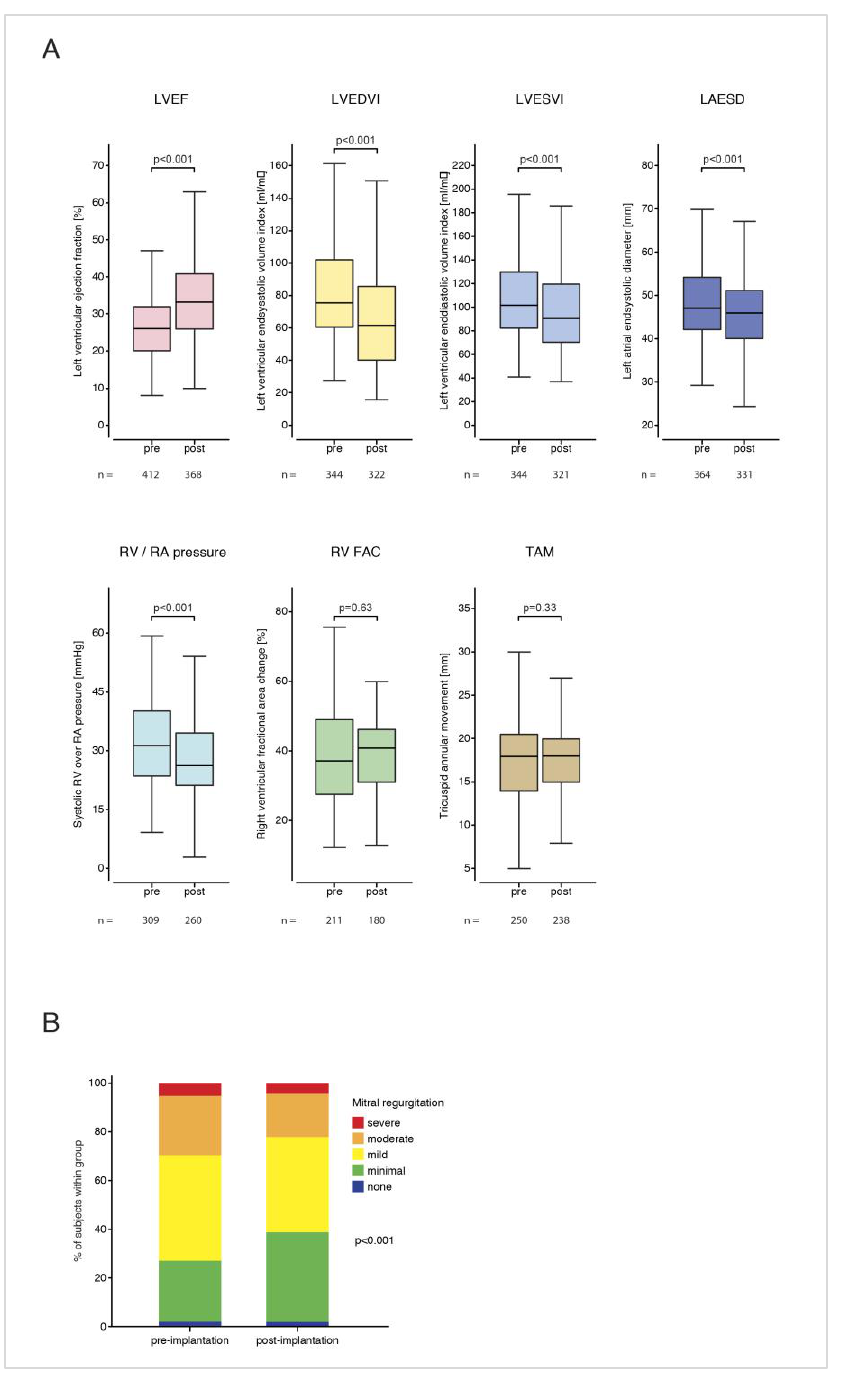
Figure 2: Effects of cardiac resynchronisa- tion therapy (CRT) on echocardiographic re- verse remodelling. Comparisons pre- vs post-CRT implantation of echocardio- graphic parameters of cardiac remodelling. (A) Comparisons of LVEF (left ventricular ejection fraction), LVEDVI (left ventricular end-diastolic volume index), LVESVI (left ventricular endsystolic volume index), LAESD (left atrial endsystolic diameter), RV/RA (systolic right ventricular over right atrial pressure), RV RAC (right ventricular fractional area change), TAM (tricuspid an- nular movement). (B) Comparison of mitral regurgitation. Wilcoxon singed rank tests. Box plots show interquartile ranges, whisk- ers indicate minimum and maximum val- ues. Median follow-up time of 6 months. Follow-up echocardiographic data were available for 369 patients